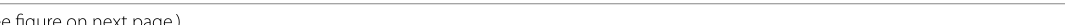
(See figure on next Fig. 6 Synazol red 6HBN dye enters into the cell ( A. aquatilis 3c) by unknown mechanism. Upon entrance into the cell the dye is enzymatically processed into various end products. Most probably, azo group (–N N–) is reduced, followed by cleavage reaction and different end products = are produced. Secondly, desulfonation and oxidative deamination results in synthesis of pyrrolo[ 1,2 - a ]pyrazine-1,4-dione derivative which can be used as substrates in amino acid metabolism. The amino acid catabolism can synthesize pyruvate (3C compound) which can be converted into acetyl-CoA. The acetyl-CoA undergoes Krebs cycle to produce NADH 2 and FADH 2 (substrates of electron transport chain). Moreover, dye desulfonation, oxidative deamination and carboxylation lead to produce phthalate derivatives, which can be transformed into different fatty acids and aldehydes. The phthalate, fatty acids and aldehydes can directly/indirectly enter into fatty acid oxidation reactions (β-oxidation) to produce acetyl-CoA, NADH 2 and FADH 2